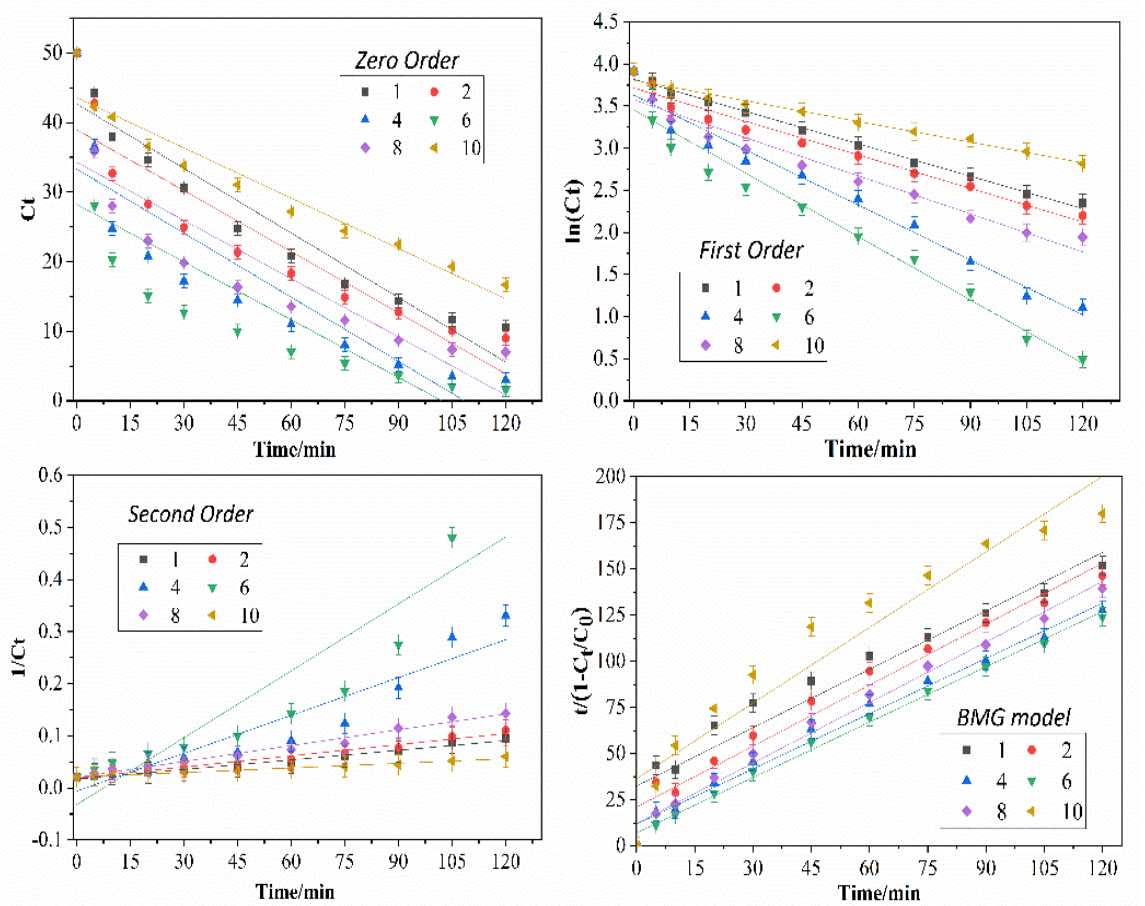
Figure 8. Degradation data of glyphosate using different kinetic models under different molar ratios of Ca 2+ :Fe 2+ .